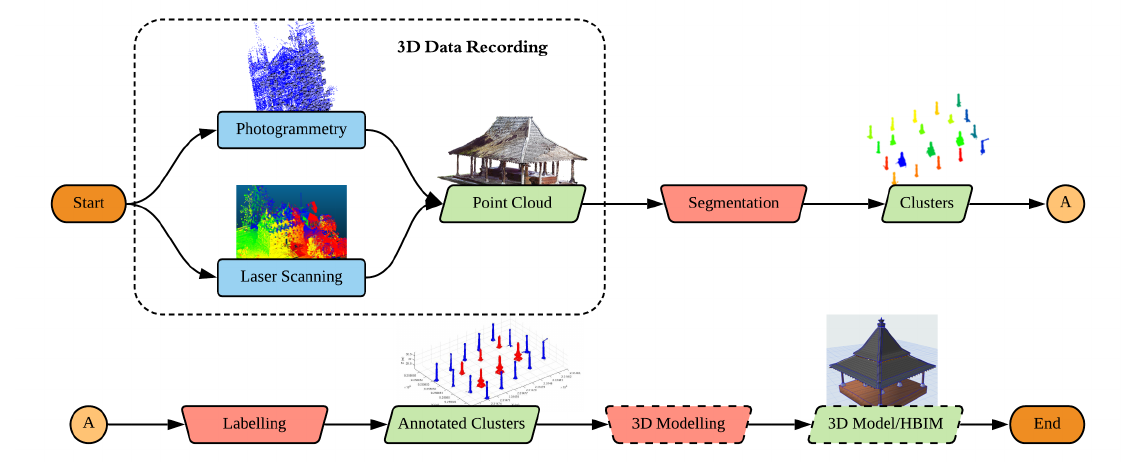
Figure 1. The overall 3D pipeline for the 3D reconstruction of historical edifices, from a point cloud up to HBIM (Heritage Building Information Model)-compatible 3D models. This paper will focus on the manual bottlenecks of the pipeline (red inverted trapeziums) up to before the 3D modeling process (long-dashed elements), although a preliminary result of automatic 3D modeling of beam structures will also be briefly